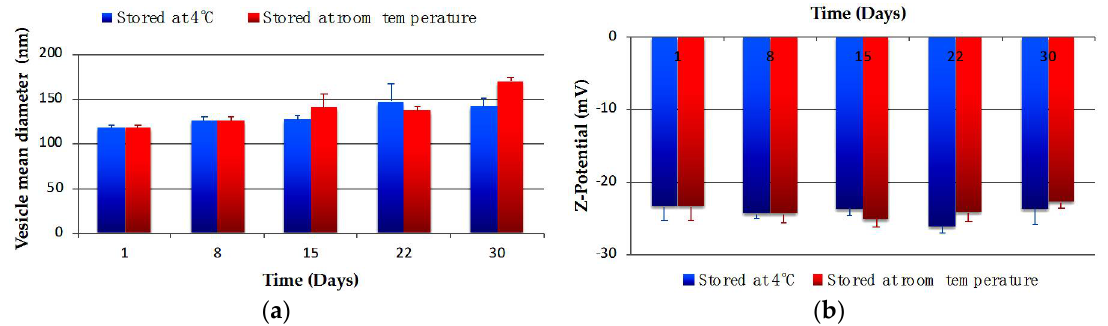
Figure 2. Changes of CG-Nio in ( a ) hydrodynamic diameter and ( b ) ζ-potential within 30 days at different storage temperatures. Values represent the mean ± standard deviation of n = 3 niosome sample measurements.